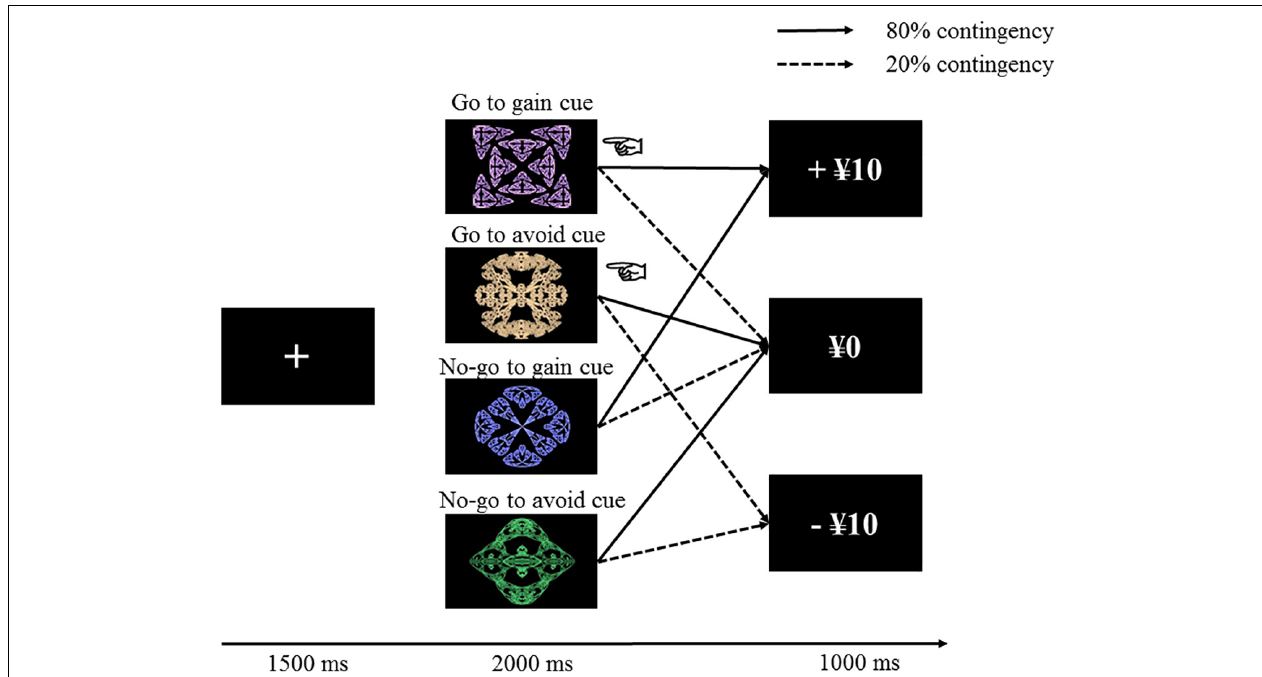
FIGURE 1 | Task structure in this experiment. Correct actions often lead to desirable results (increasing 10 yen in the gain cue and preventing a loss of money in the avoidance cue), whereas incorrect actions generally lead to undesirable consequences (omitting the reward and receiving the punishment). The pointing finger in this figure is depicted as a go